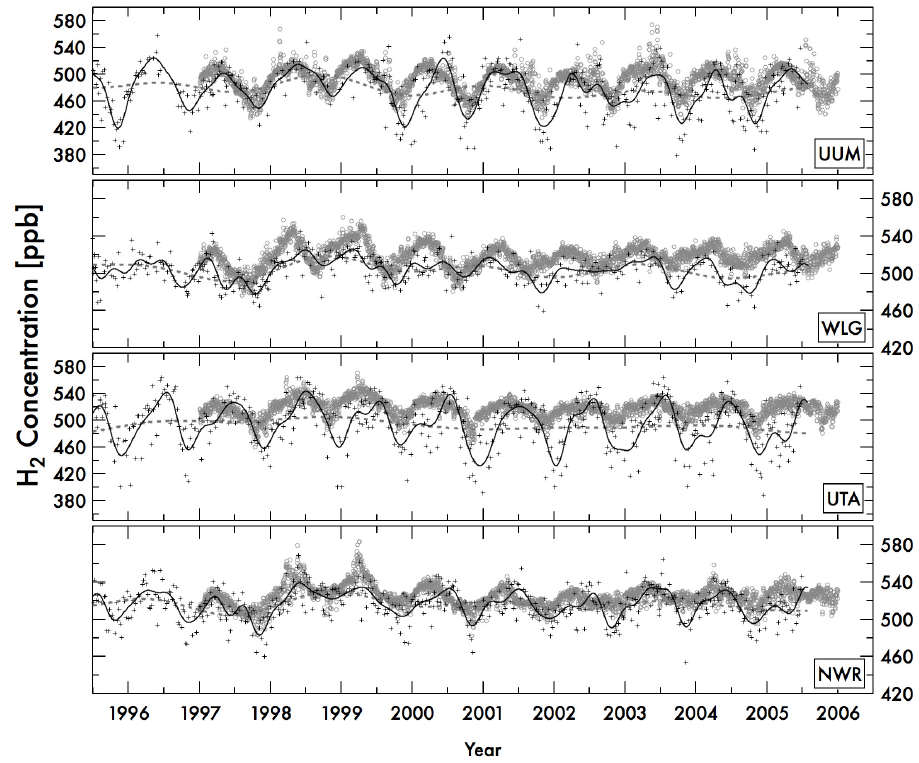
Fig. 3b. Same as Fig. 3a, but for UUM(44.5 ◦ N), WLG(36.3 ◦ N, 3810m), UTA(39.9 ◦ N), NWR (40.0 ◦ N, Fig. 3b Same as Fig.3a, but for UUM(44.5°N), WLG(36.3°N, 3810m), UTA(39.9°N), NWR (40.0°N, 3523m)